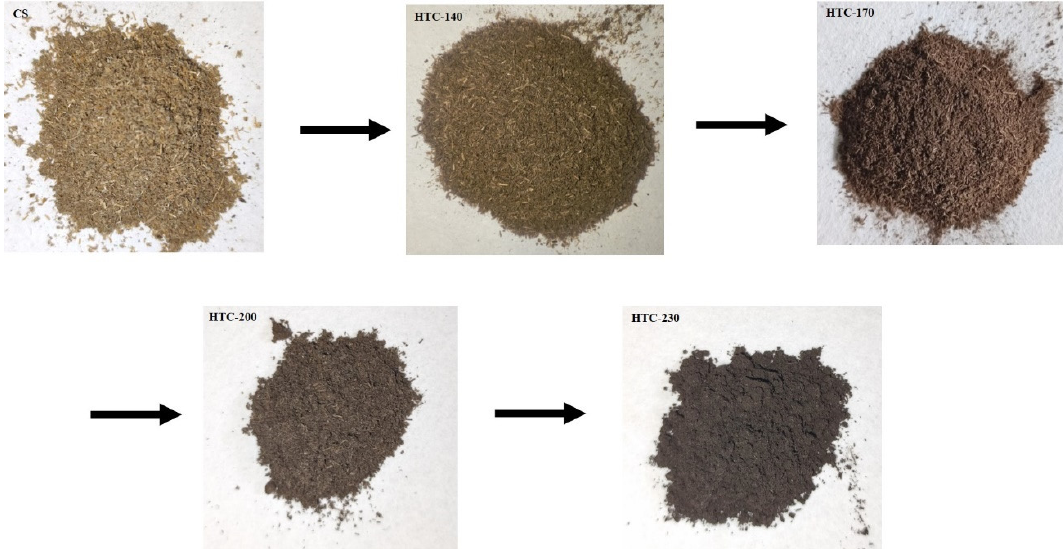
Figure 2. The sample changes of corn straw after the hydrothermal reaction.